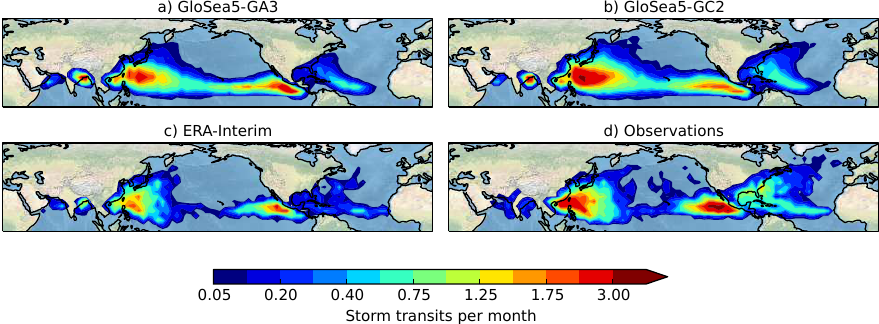
Figure 14. Seasonal hindcast (SEAS experiment) tropical cyclone track densities obtained using TRACK for JJA 1996–2009. (a) GloSea5- GA3, (b) GloSea5-GC2, (c) ERA-I, (d) observations (North Atlantic and eastern Pacific from HURDAT; western North Pacific and North Indian Ocean from the US Navy’s Joint Typhoon Warning Centre (JTWC) best-track (Chu et al., 2002).